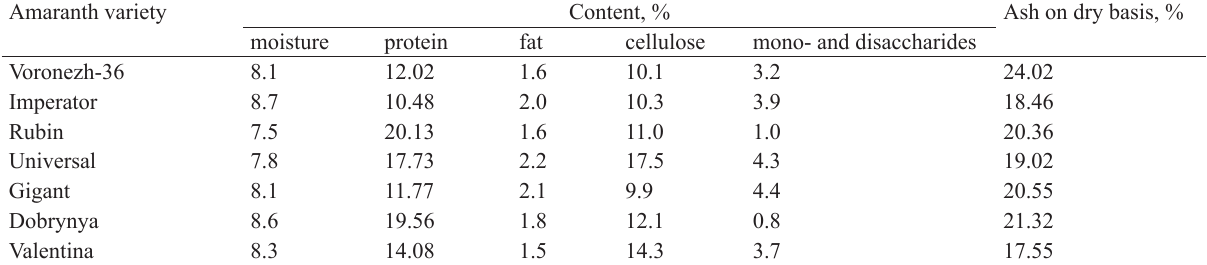
Table 3 Amaranth leaf mass composition Amaranth variety Content, % Ash on dry basis, % moisture